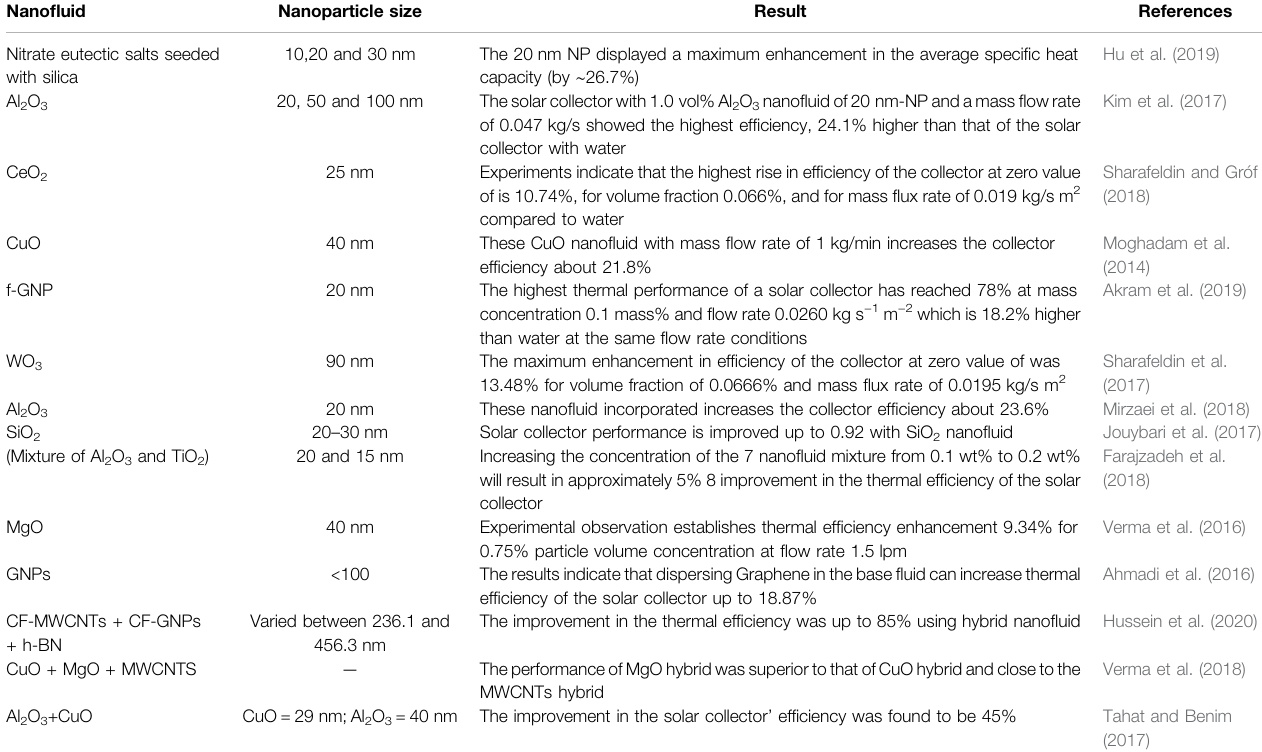
TABLE 2 | Summary of nano fl uids used in solar